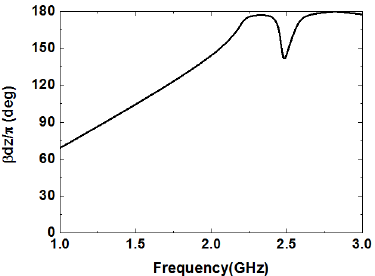
Figure 3. Dispersion diagram of the microwave sensor based on the CCSR.